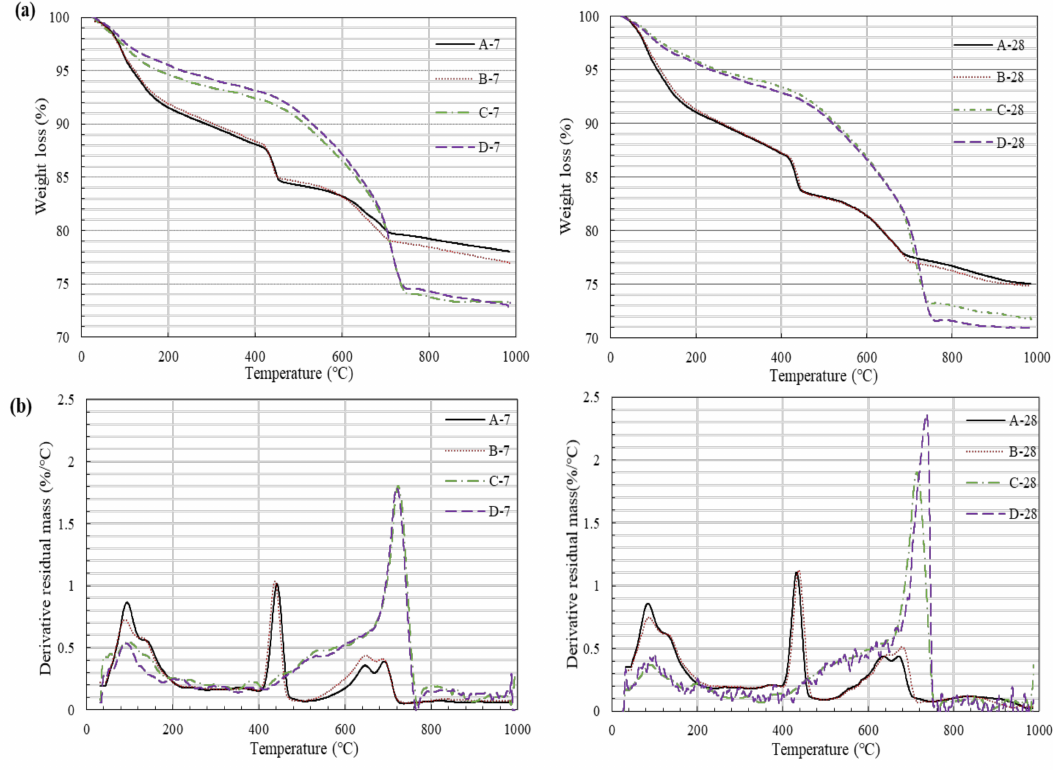
Figure 6. ( a ) Thermogravimetry (TG) and ( b ) Differential thermogravimetry (DTG) analysis results after 7 and 28